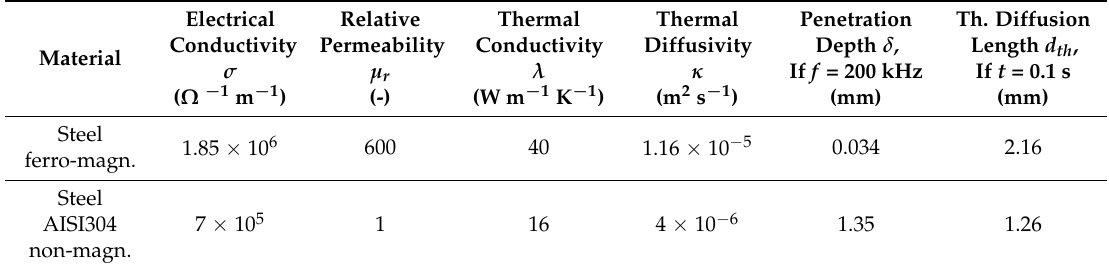
Table 1. Material